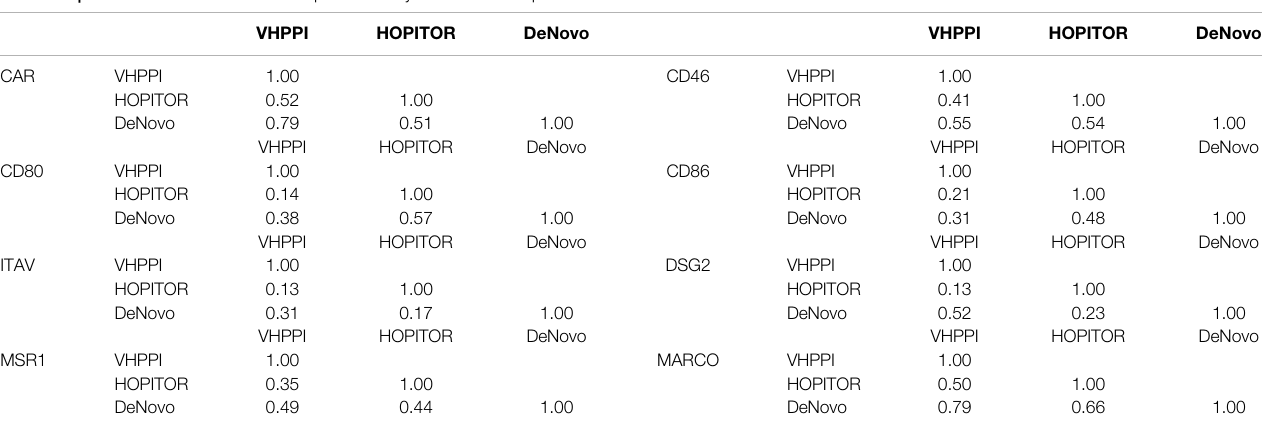
TABLE 1 | Correlation coef fi cients of PPI predictors by adenoviral receptor. VHPPI HOPITOR DeNovo VHPPI HOPITOR